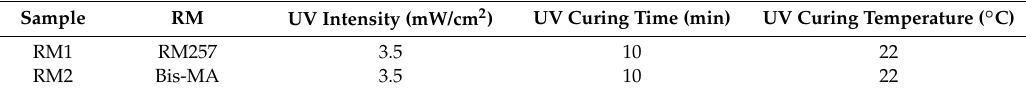
Table 3. With regard to the types of the reactive monomer, two different reactive monomers—either RM257 or Bis-MA were added to ZLI-4792 at 0.5%. In each mixture, the added amount of PI was 1% with respect to the RM.